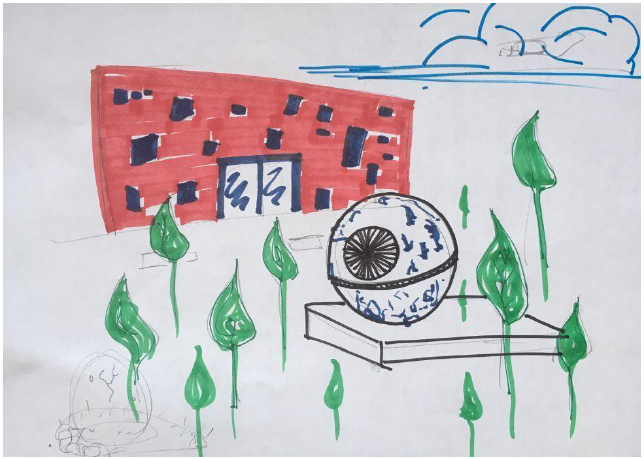
21 www.img-network.it